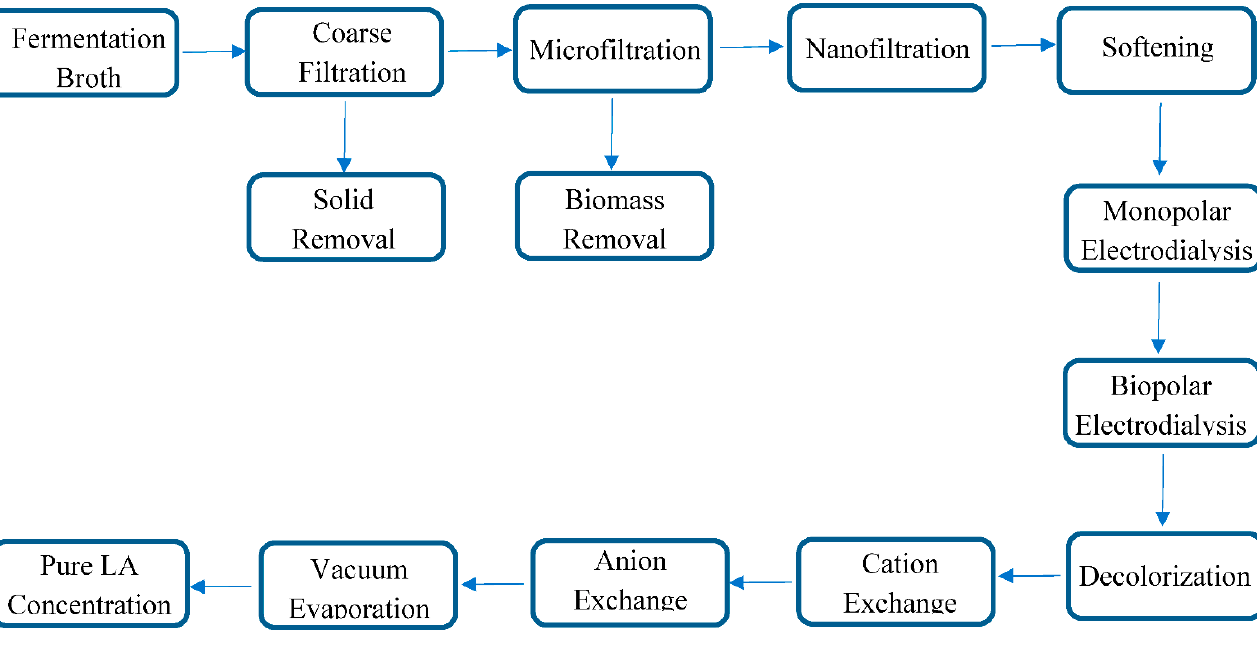
Figure 1. Outlines of the downstream process of lactic acid.